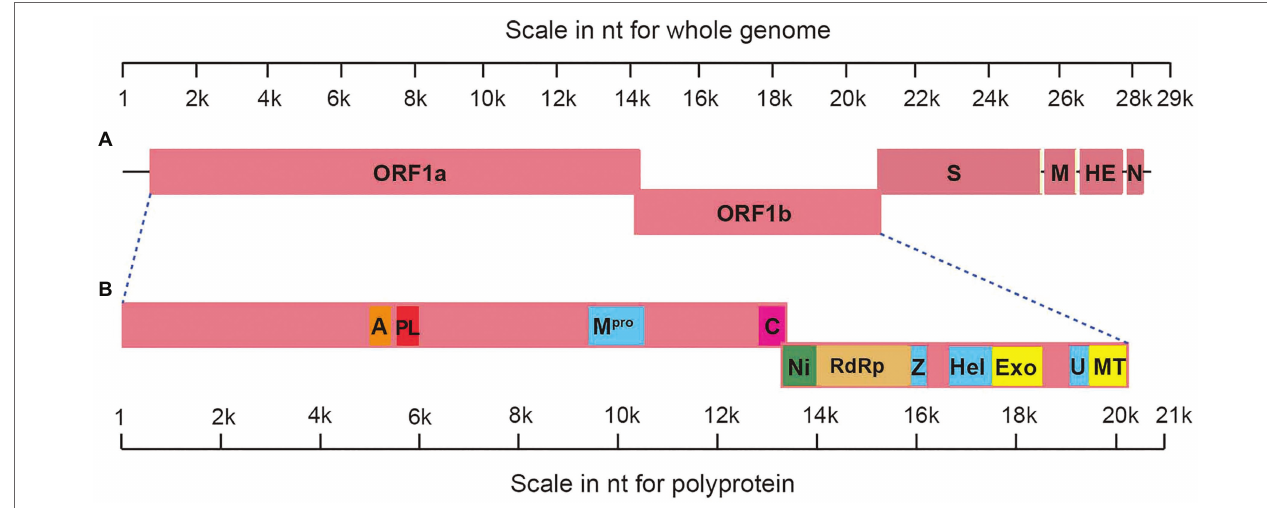
FIGURE 2 | Genomic organization of AToV. (A) Schematic representation of AToV genome; (B) schematic representation of pp1ab. Conserved domains are highlighted as follows: a represents ADRP, residues V1645-C1773; PL represents PLP, residues G1820-L1968; M pro , residues S3131-Q3417; C represents CPD, residues Q4269-D4439; Ni represents NiRAN, residues F4440-R4650; RdRp, residues P4651-Q5233; Z represents ZBD, residues S5284-L5365; Hel, residues V5538-V5813; Exo represents ExoN, residues S5842-V6171; U represents NendoU, residues G6316-Q6465; MT, residues R6466-H6730.